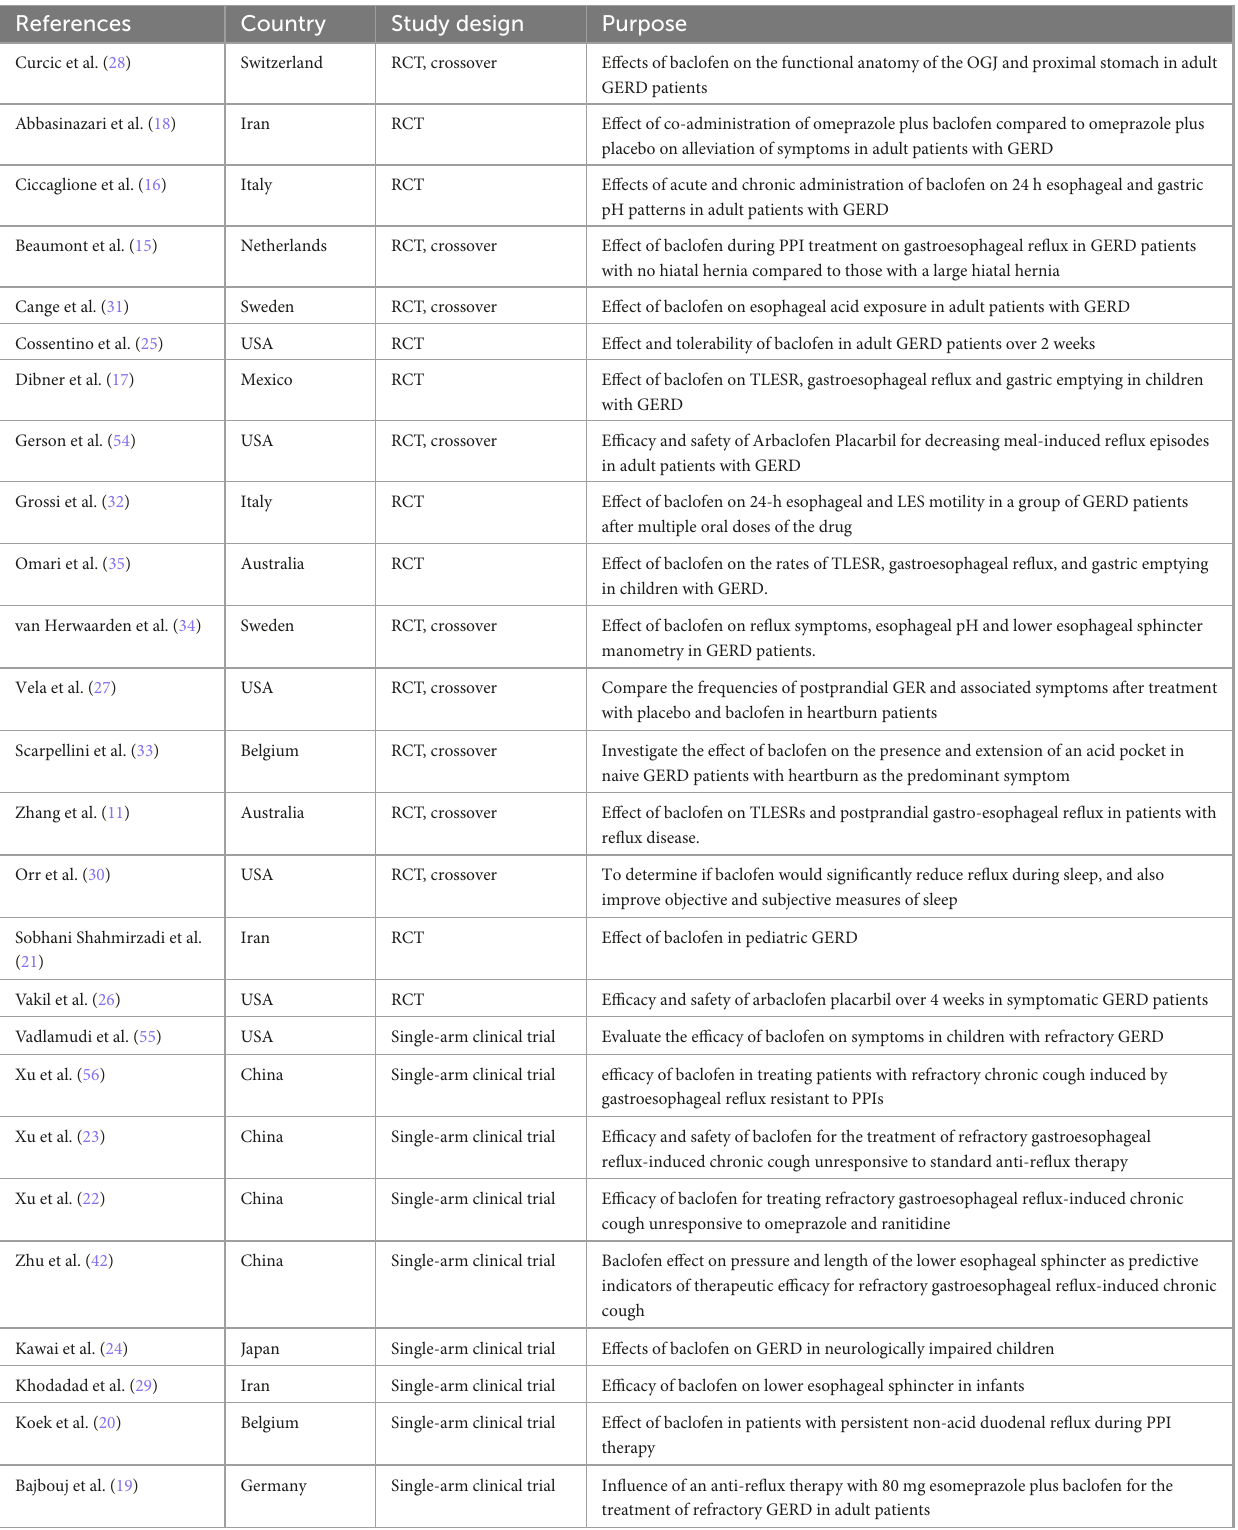
TABLE 1 Characteristics of included